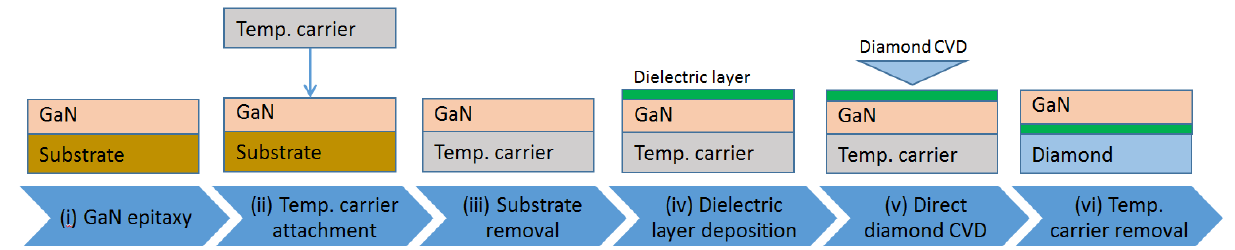
Figure 2. GaN-on-diamond fabrication steps.